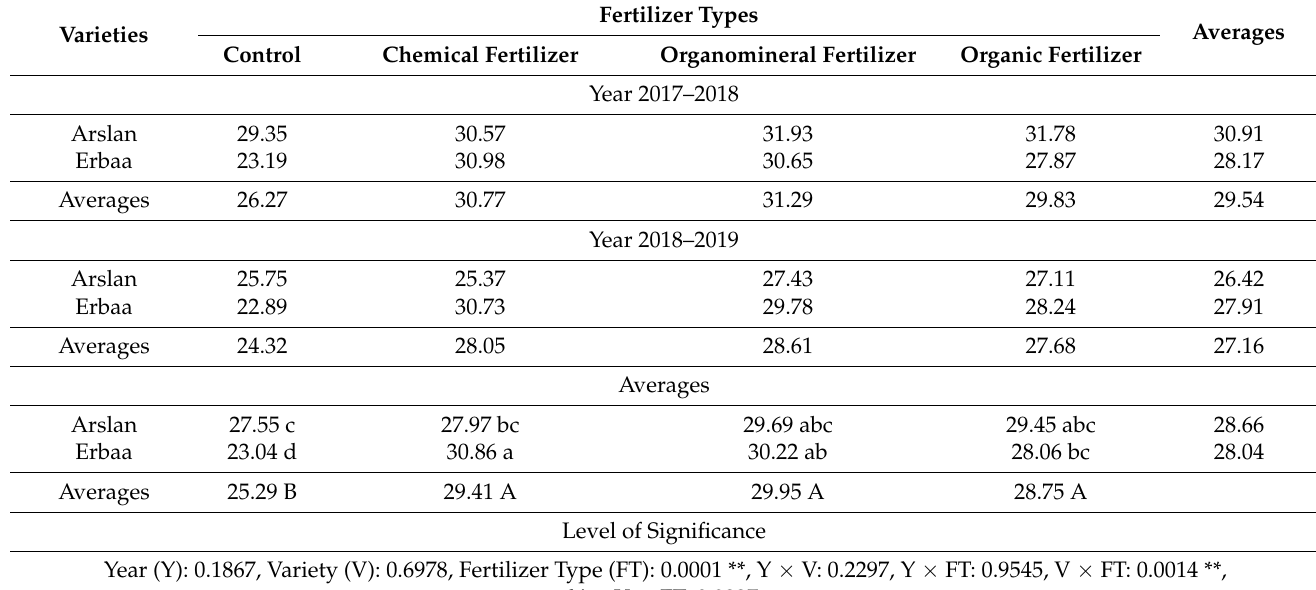
Table 8. The effect of fertilizer types on the harvest index of coriander varieties (%) 1 . Varieties